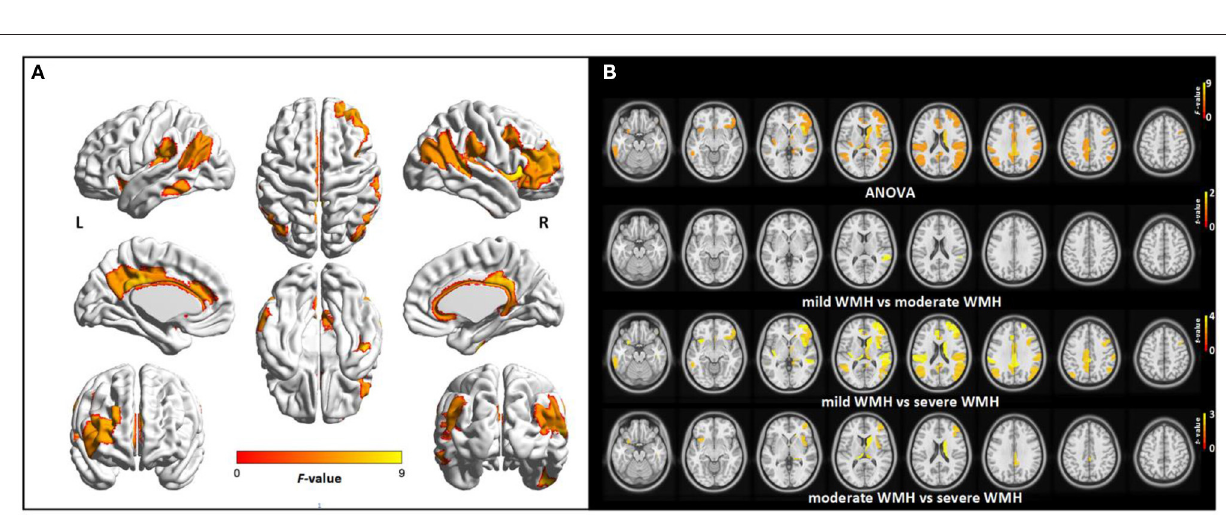
FIGURE 2 | Group differences in regional CBF among subjects with different WMH loads controlling for age and sex. (A) Surface statistical maps displaying F -scores of ANOVA for altered CBF among three groups ( p < 0.01, with permutation test for 1,000 times). (B) Axial statistical maps displaying F -scores of ANOVA and t- scores of post-hoc analysis between every two groups. In statistical maps of ANOVA, warmer colors indicate significant differences in local CBF among three groups. In statistical maps of post-hoc analysis between every two groups, warm colors represent regional CBF decrease in moderate WMH group compared with mild WMH group, or in severe WMH group compared with mild WMH group, or in WMH3 group compared with moderate WMH group, respectively. L, left; R,